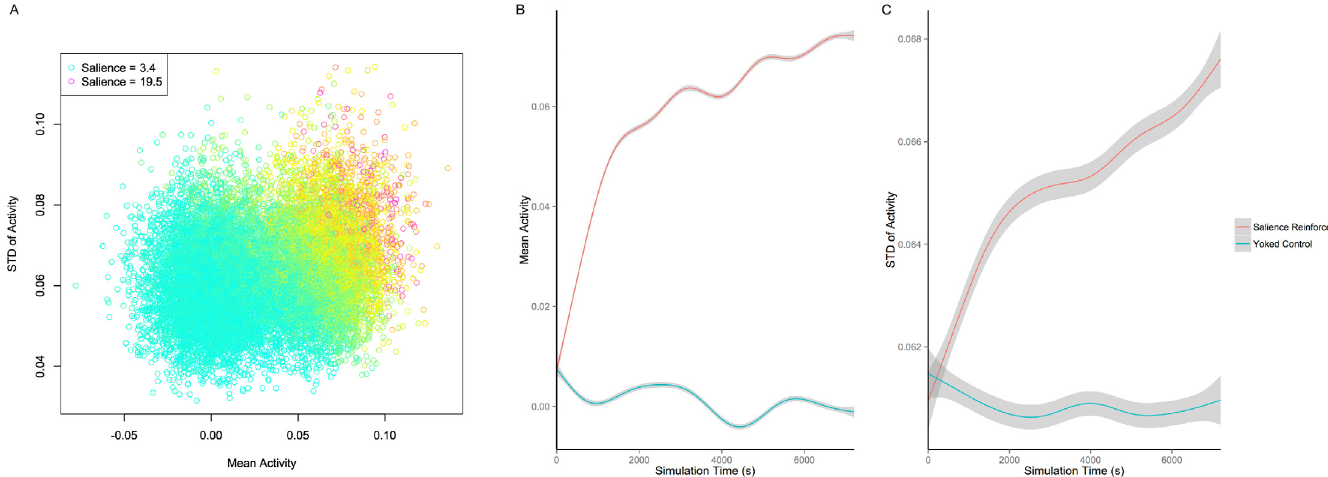
Fig 4. The relationship of muscle activity mean and standard deviation to salience and learning. A: Each point represents one vocalization produced by five simulations of the salience-reinforced model. Data are sampled so that every fifth vocalization produced by the model is plotted here. Note that the most salient sounds tend to have both high median activity levels and high standard deviation of muscle activity, as our statistical analyses indicate. The legend shows the colors of the maximum and minimum salience points portrayed in the plot; red indicates high salience, yellow indicates moderate salience, and cyan indicates low salience. B: The mean level of muscle activity produced by the model as a function of simulation time in seconds and whether the simulation was reinforced based on auditory salience or was a yoked control. Lines are generalized additive model fits and dark gray shading gives 95% confidence intervals around those fits. When reinforced for auditory salience, the model increases the baseline level of activity of the masseter and orbicularis oris muscles, leading to greater mouth closure on average after learning. The yoked controls do not show such an increase. C: The average, across vocalizations, of the standard deviation of muscle activity within each vocalization, as a function of simulation time in seconds and whether the simulation was reinforced based on auditory salience or was a yoked control. The salience-reinforced model increases its within-vocalization change in activity of the masseter and orbicularis oris muscles, leading to greater jaw and lip movement on average after